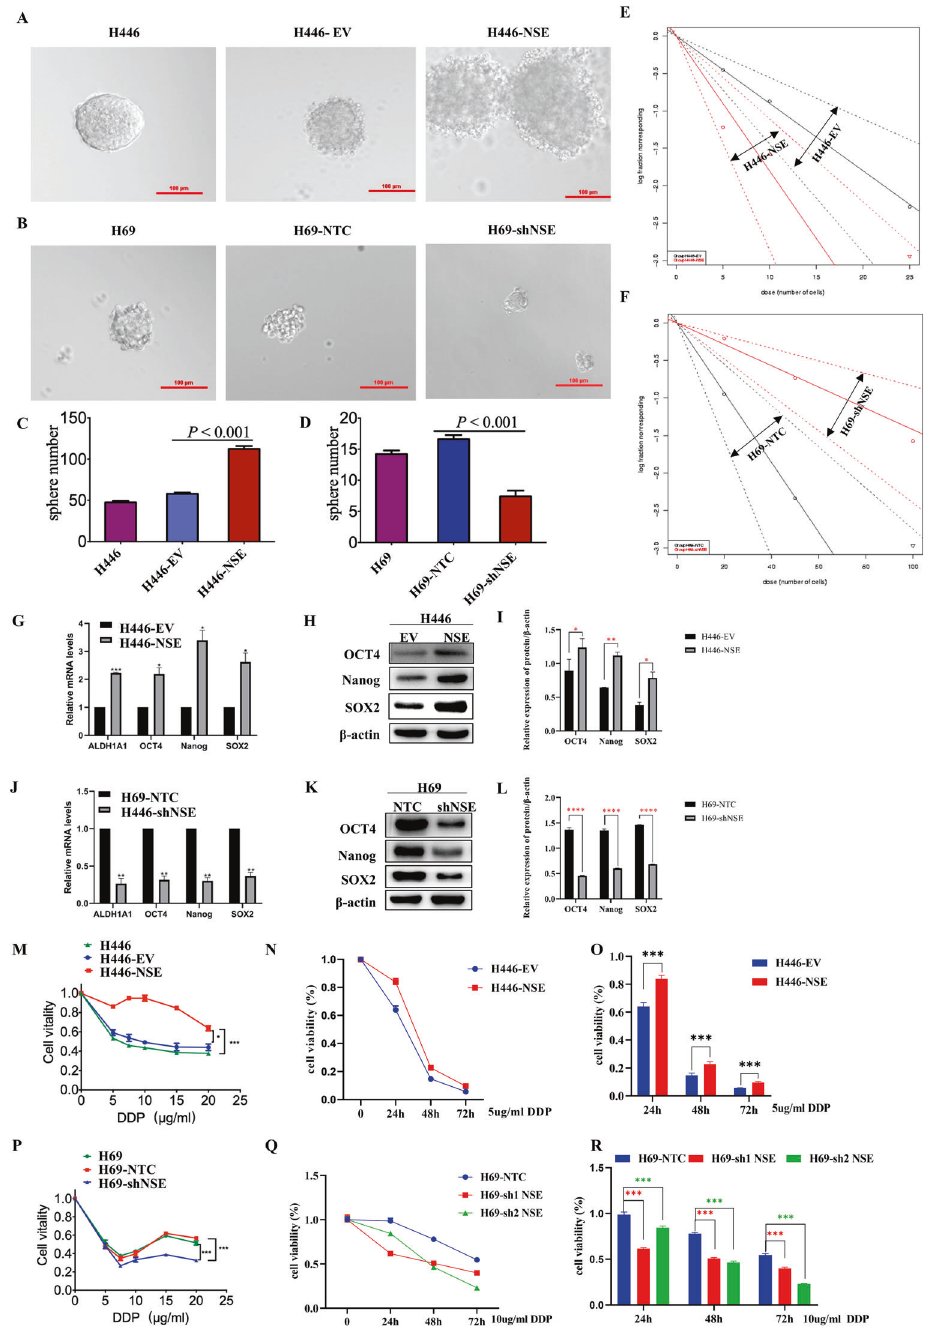
Fig. 3 NSE modulates the stem cell-like characteristics of SCLC cells. The self-renewal capability of SCLC cells was determined by assessing the sphere formation. A Representative morphology of the sphere formed by NSE-overexpressing cells (original magni fi cation ×20, scale bar 100 μ m). B Representative images of sphere formation were displayed after 14 days of culture in NSE-knockdown cells (original magni fi cation ×20, scale bar 100 μ m). C The bar charts represented the percentage of spheroid cells of NSE-overexpressing cells compared to the control cells. D The bar charts represented the percentage of spheroid cells of NSE-knockdown cells compared to the control cells. E , F The stemness property of H446 cells ( E ) and H69 cells ( F ) was evaluated by the Extreme Limiting Dilutions Analysis website. The mRNA ( G ) and protein levels ( H ) of stemness-associated genes upon NSE overexpression were detected. I The relative protein expression (protein/ β -actin) was analyzed by ImageJ software and quanti fi ed in a column graph. NSE knockdown inhibited the expression of CSC-related genes at the mRNA level ( J ) and protein level ( K ). L All western blot images were analyzed by ImageJ software, and the relative protein expression (protein/ β -actin) was quanti fi ed in a column graph. SCLC cells in indicated groups were treated with cisplatin, and the cell viability was measured using the CCK8 assay. M – O Compared with EV cells, cells overexpressing NSE showed a dose-dependent decrease ( M ) and time-dependent decrease ( N ) in the sensitivity to cisplatin. O The proportion of alive cells in SCLC cells was also shown as column graphs. P – R NSE-knockdown cells were more sensitive to cisplatin than negative control cells with a dose-dependent decrease ( P ) and time-dependent decrease ( Q ). R The percentage of alive cells in SCLC cells is also shown as column graphs. Data are represented as mean ± SD for three experiments. * P < 0.05; ** P < 0.01; *** P <